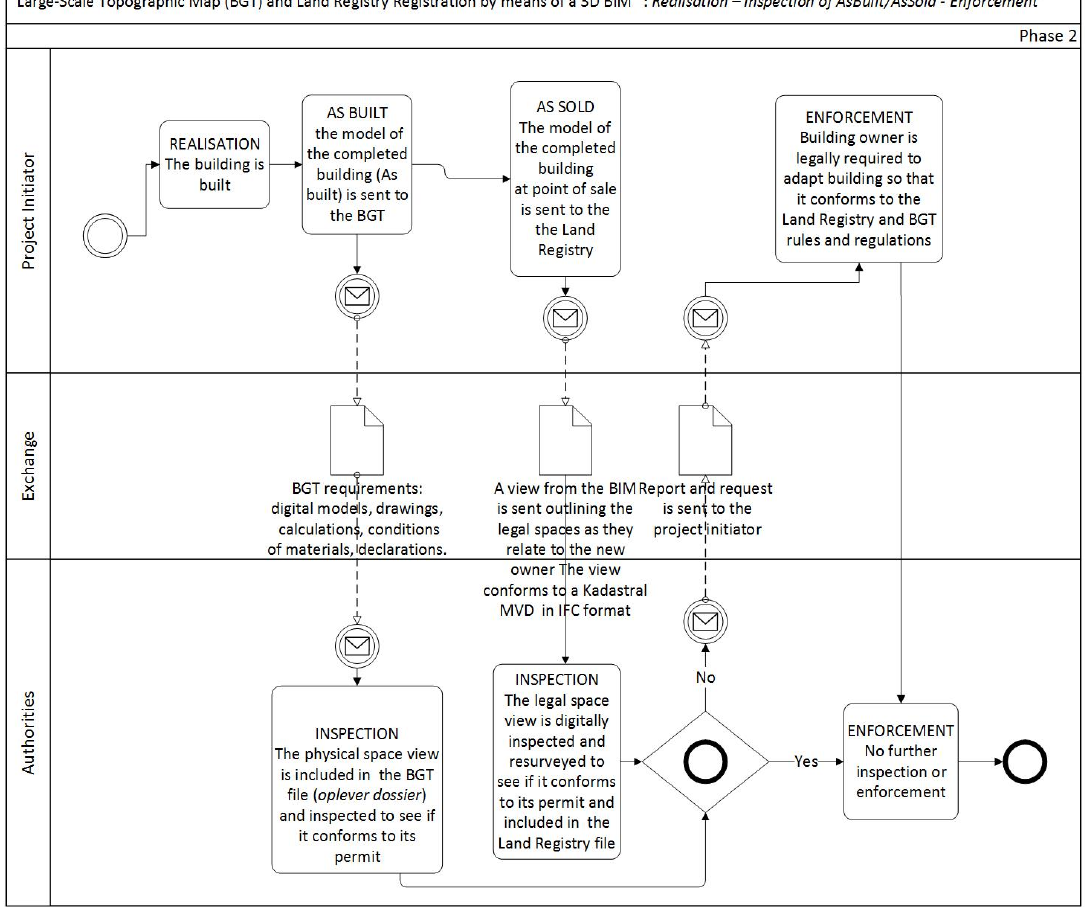
Figure 2 . Information Delivery Manual (IDM) Workflow: Cadastral Registration by means of a 3D BIM Phase 1.